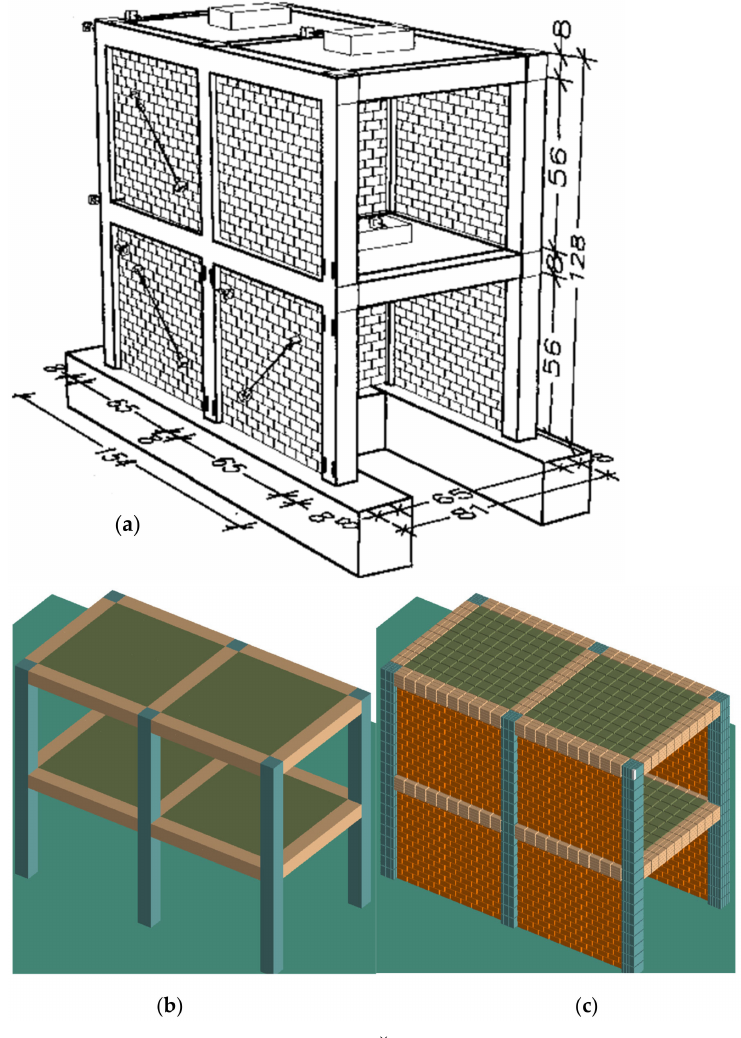
Figure 4. H-building modeled after Žarni´c et al. (2001) [24]: ( a ) perspective view; ( b ) bare frame model and; ( c ) IFM